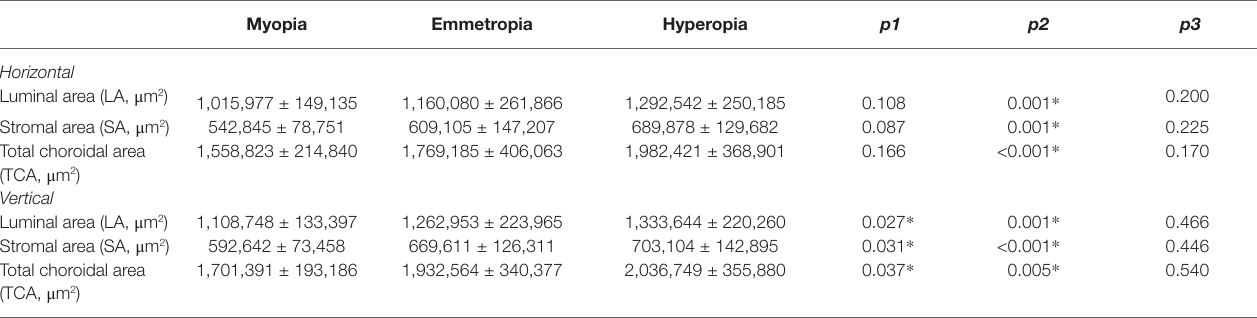
TABLE 3 | Baseline choroidal vascularity (CV) comparisons among myopia, emmetropia and hyperopia groups.